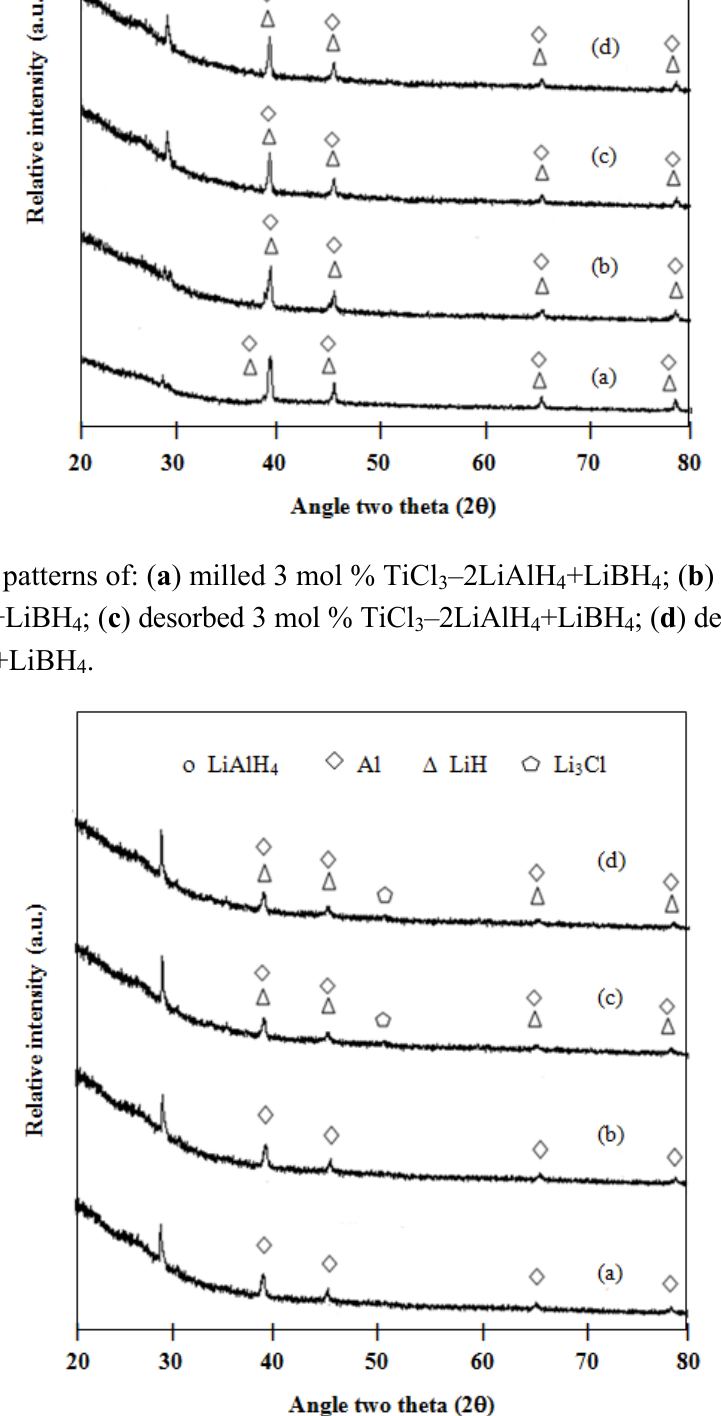
+LiBH ; 4 4 –2LiAlH +LiBH ; ( d ) 1 mol % 3 4 4 +LiBH . 4 4